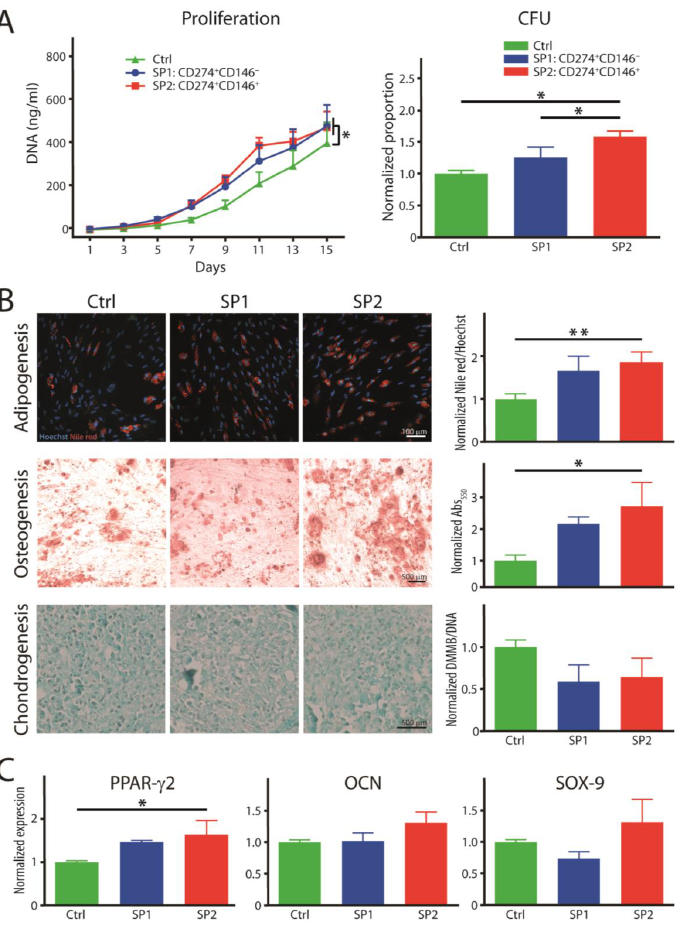
Figure 4. Functional properties of fractions sorted and expanded from the thawed ASC passage P4. ( A ) Proliferation rate and colony-forming capacity. ( B ) Histochemical analysis of trilineage differ- entiation by staining in culture with Nile red and alizarin red for adipo- and osteogenesis, respec- tively. Chondrogenesis was evaluated in paraffin-embedded and sectioned micromass cultures stained with alcian blue. The Nile red accumulation was quantitated in situ by fluorometry and the other two dyes after extraction with spectrophotometry. ( C ) Transcriptional expression of differen- tiation-representative factors by real-time RT-PCR. The complementary phenotype to the one indi- cated for the SP1 and SP2 subsets featured the CD34 − CD36 − CD200 − CD248 − CD271 − Stro-1 − marker profile. The data are presented as a mean + SEM from two independent experiments ( n = 6 – 8). * p < 0.05, and ** p < 0.01. Abbreviations: Abs, absorptions; SP, subpopulation; Ctrl, control; CFU, colony-